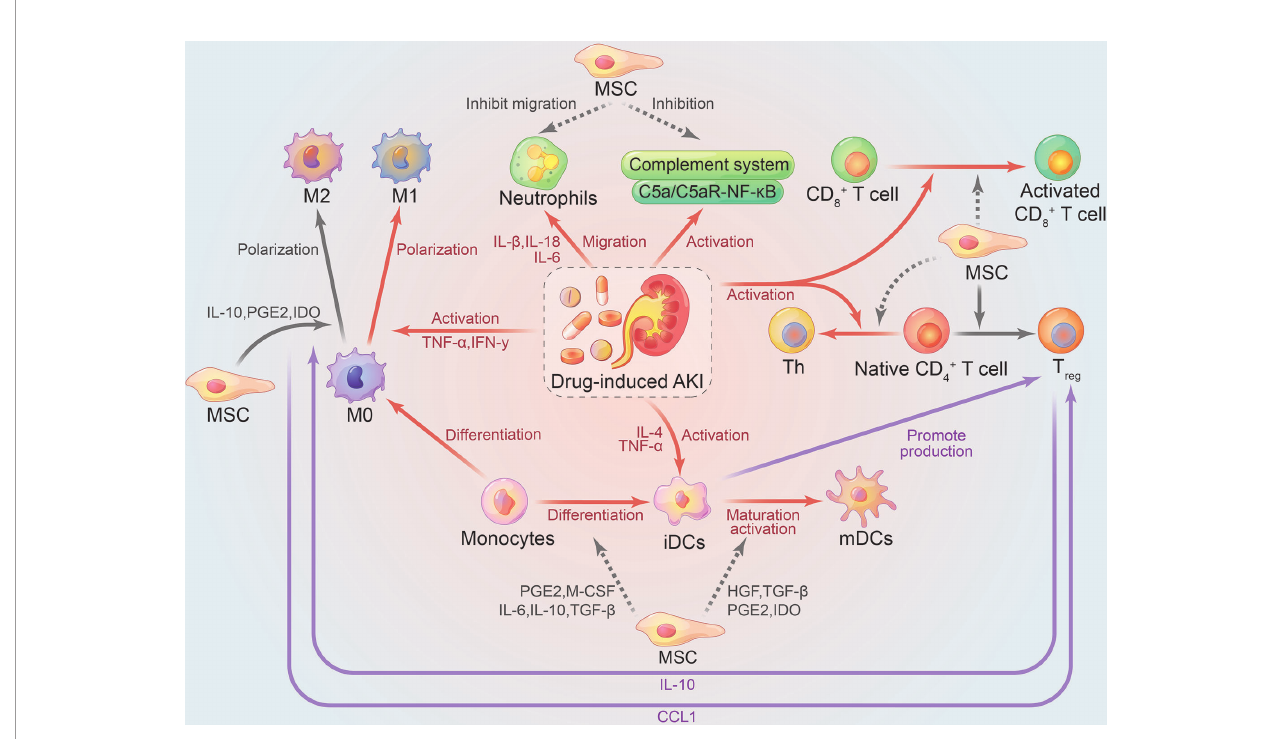
FIGURE 1 | Immunomodulatory effects of mesenchymal stem cells on drug-induced AKI. Gray, therapeutic effect of mesenchymal stem cells on the kidney; Red, damage effect of AKI on the kidney; Purple, interaction between immune cells; Solid line, promoting effect; dashed line, inhibiting effect. AKI, acute kidney injury; iDCs, immature dendritic cells; mDCs, mature dendritic cells; Th, helper T cells; Treg, CD3 + CD4 + CD25 + Foxp3 + regulatory T cells; HGF, hepatocyte growth factor; IDO, indoleamine 2,3-dioxygenase; PGE2, prostaglandin E2; TGF- b , transforming growth factor b